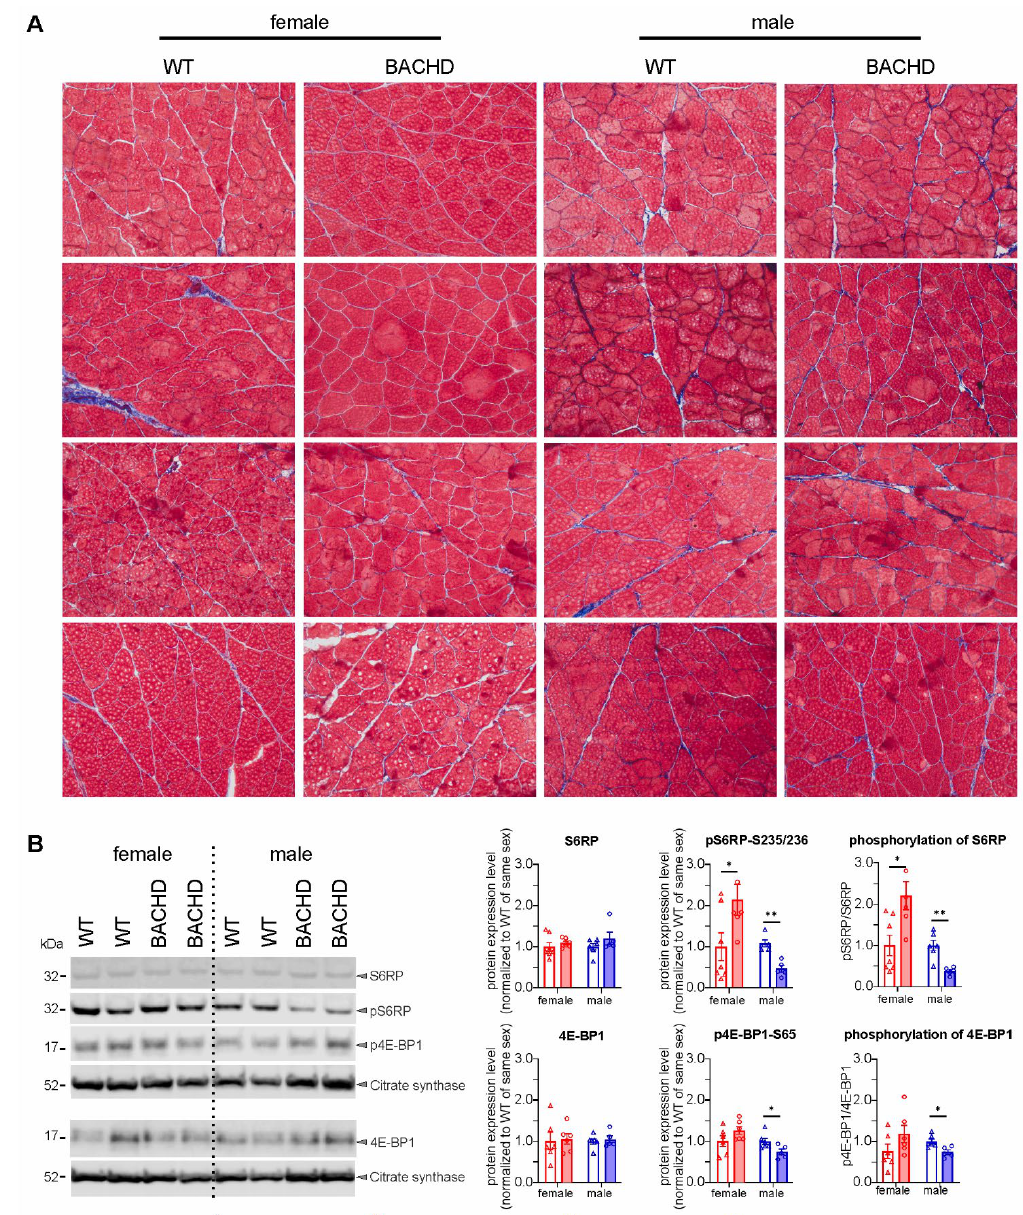
Figure 2. Muscle morphology and quantification of proteins regulating growth and cell proliferation. ( A ) Trichrome stain shows overall a comparable collagen tissue content (blue) and muscle fibers (red) in female or male BACHD rats compare to WT littermates of the same sex ( n = 4/geno- type/sex). ( B ) Levels of S6RP and 4E-BP1 (total protein, phosphorylated protein and phosphory- lated/total protein) were compared between genotypes within each sex (female: n = 6/genotype; male: n = 5–6/genotype). Data are expressed as mean values ± SEM. Statistical significance was determined by Student’s t -test. * p ≤ 0.05; ** p ≤ 0.01 .